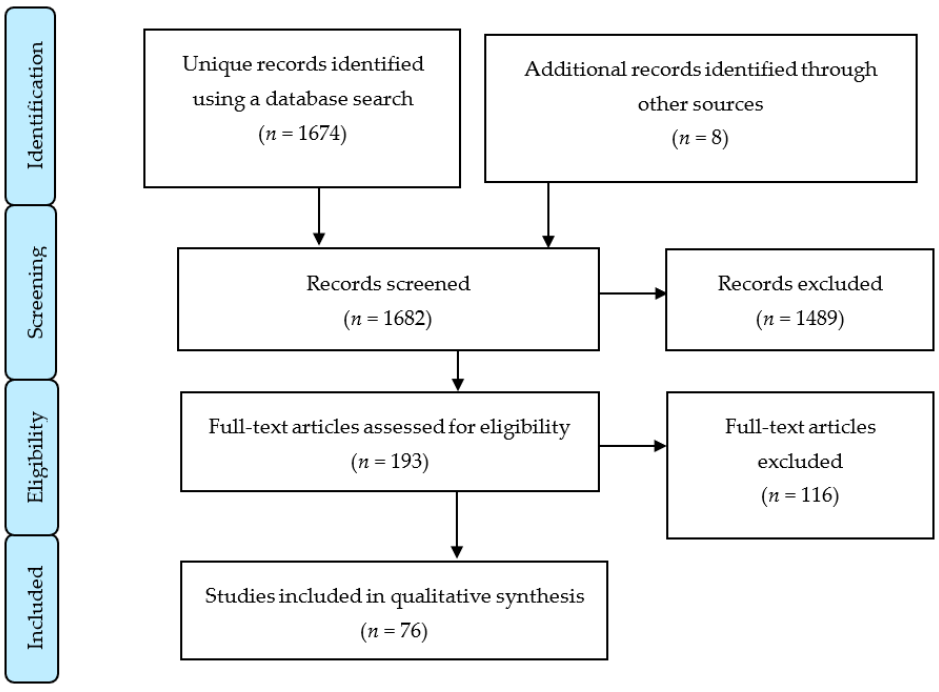
Figure 1. Flow diagram.